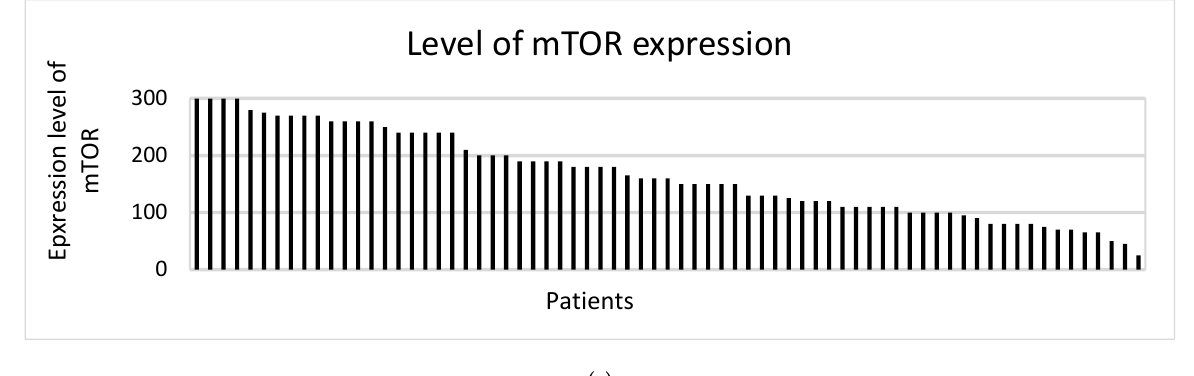
Figure 1. ( a ) Representative image of high expression of mTOR (IHC score = 300). ( b ) Representative image of low expression of mTOR. (Images by kind courtesy of Prof. Dr. Müllauer). ( c ) Level of mTOR expression in 71 patients with therapy − refractory solid tumors. Scale bar = 100 µ m.